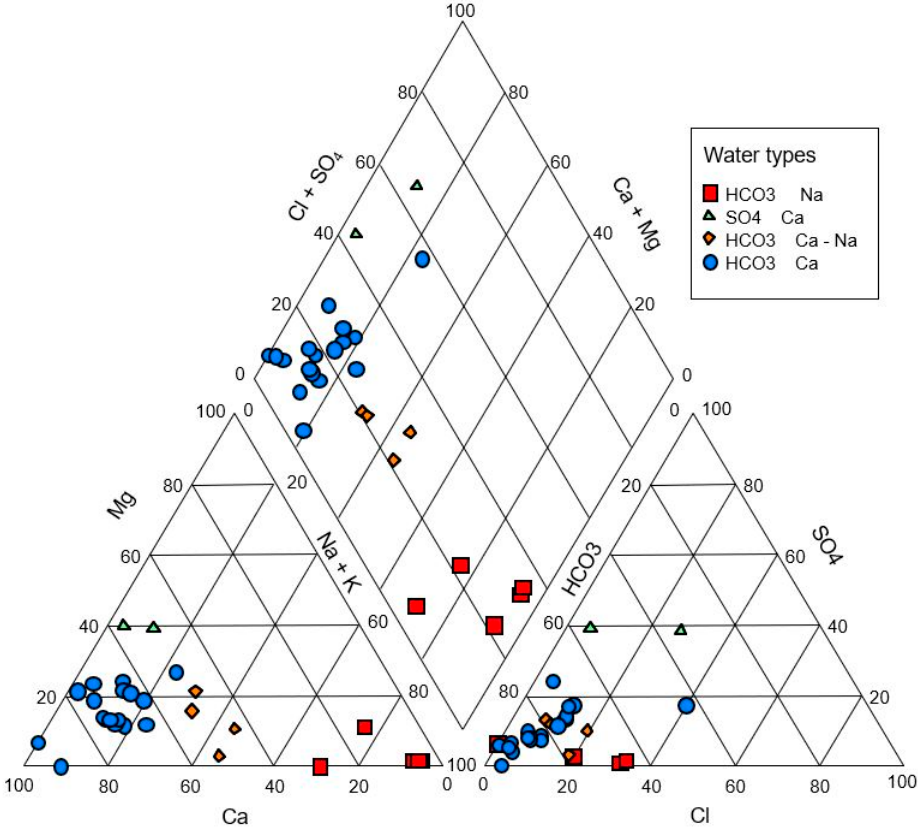
Figure 4. Piper diagram of all the bottled mineral waters showing the different water types.